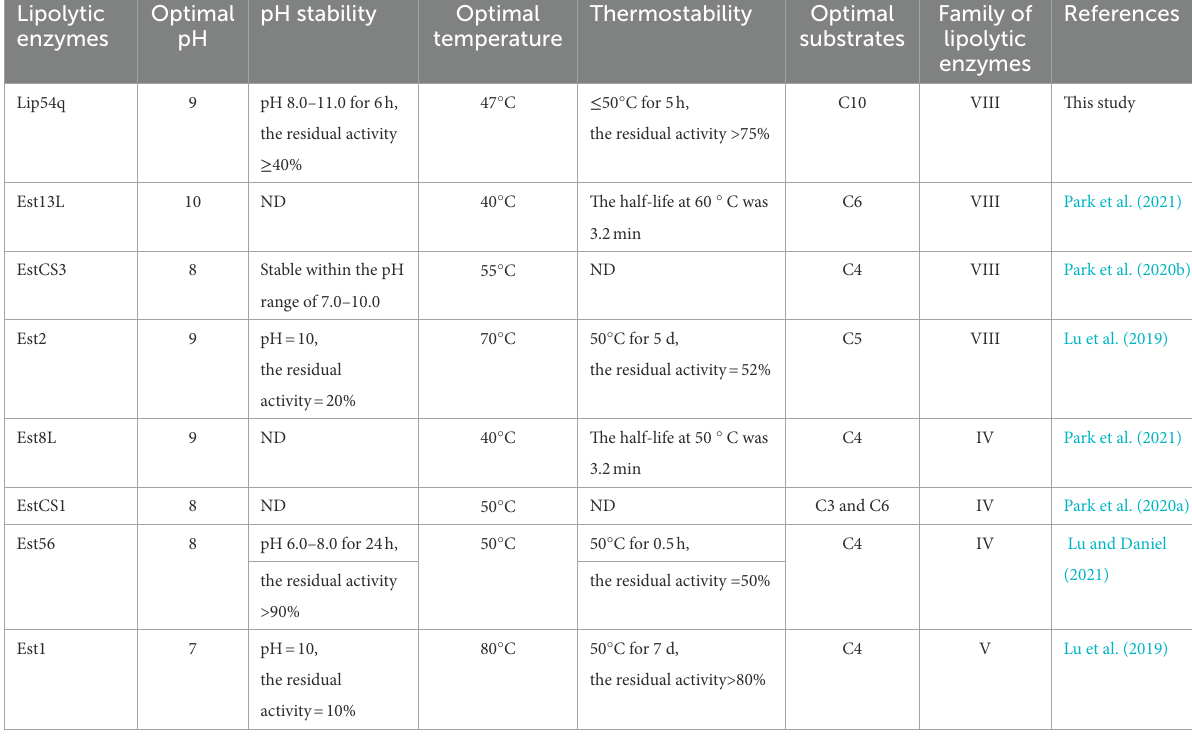
TABLE 5 Comparisons of enzymatic properties of Lip54q with several lipolytic enzymes also derived from compost habitats. Lipolytic Optimal pH enzymes pH